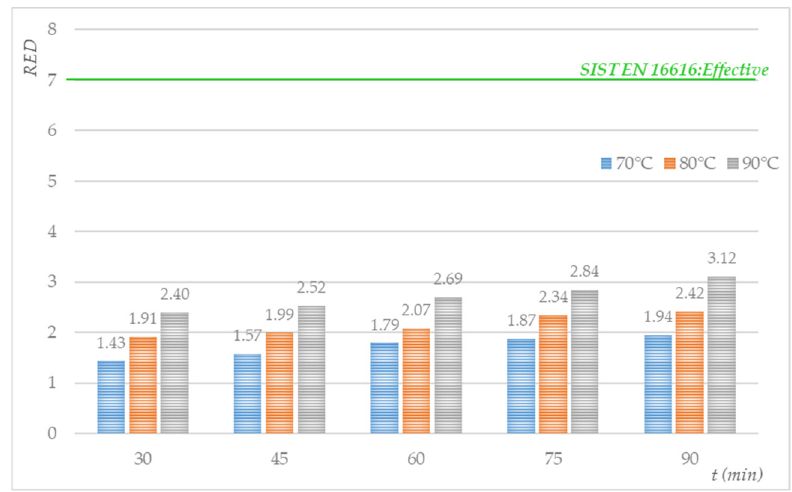
Figure 2. Log step reduction in S. aureus on textile bioindicators thermally treated in a heating oven (average N 0 = 1.47 × 10 7 CFUs/mL).